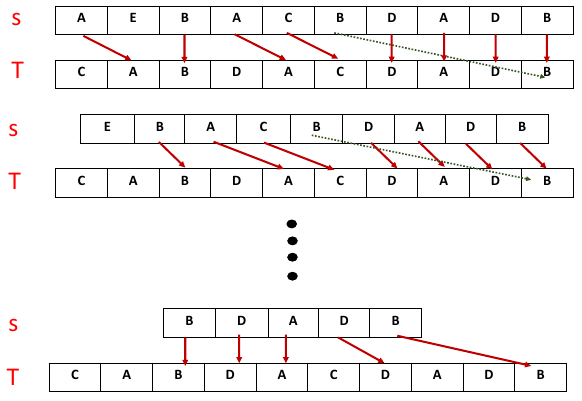
Figure 1. An overview of the proposed similarity computation